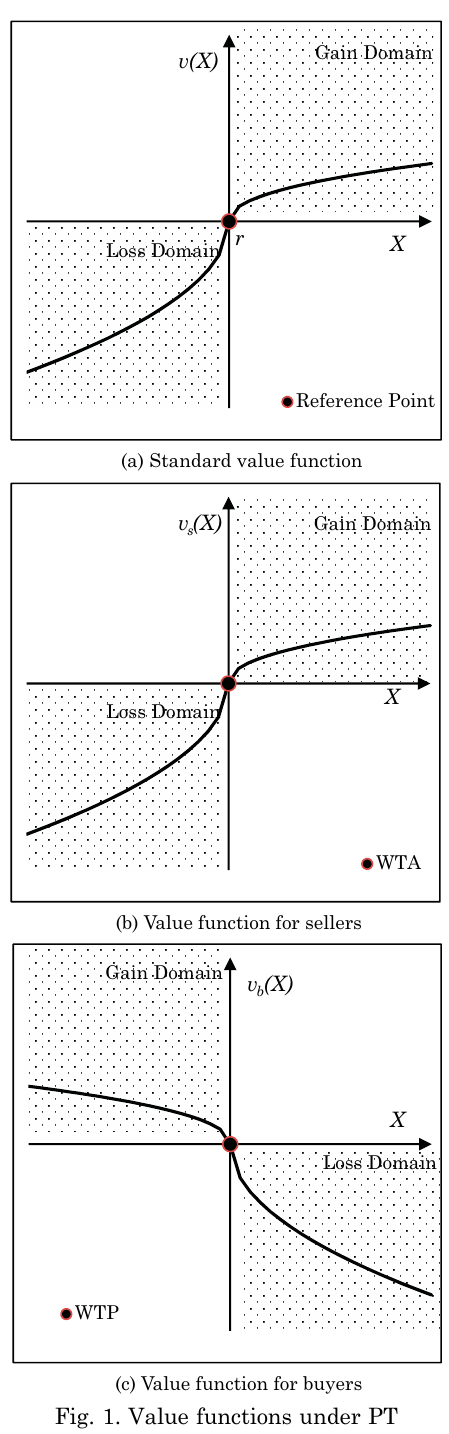
fig. 1. Value functions under